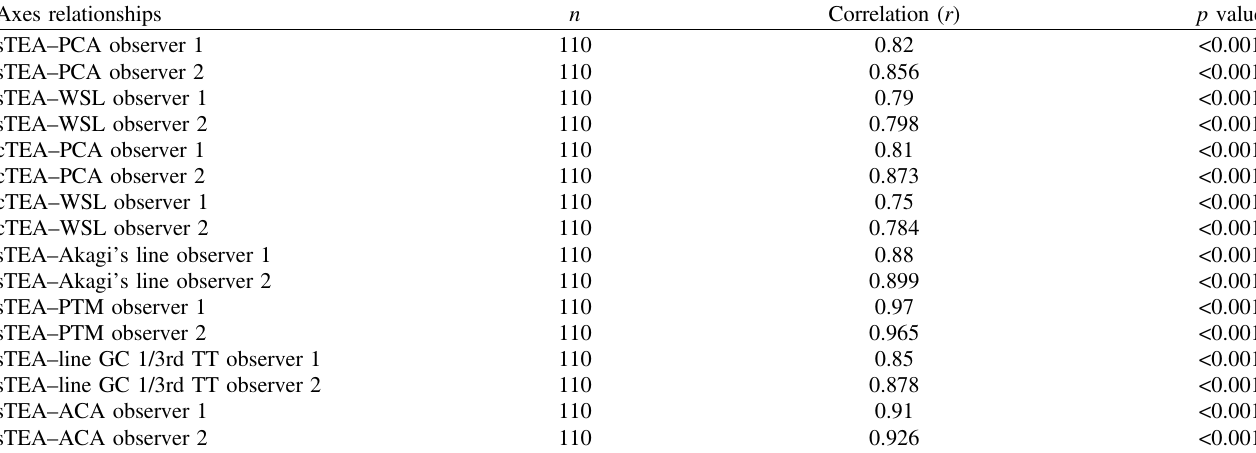
Table 6. Intraobserver reliability among different axis relationships. Axes relationships